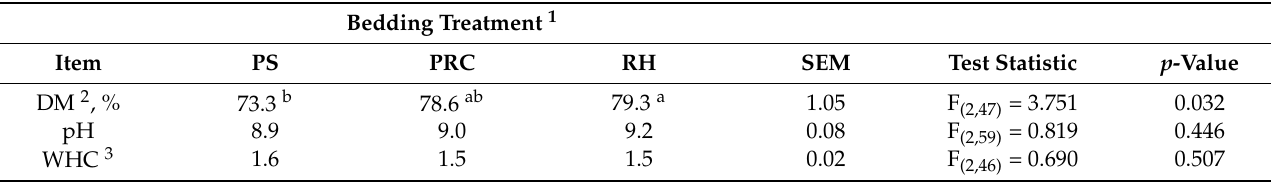
Table 2. Physicochemical properties of the bedding materials. Bedding Treatment